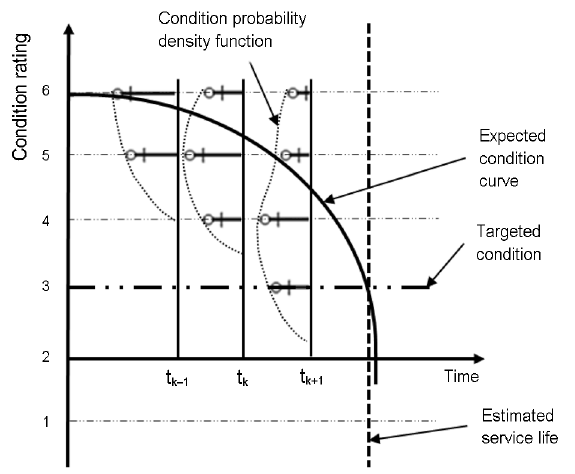
Fig. 5. Service life prediction (based on Hovde, Moser 2004)